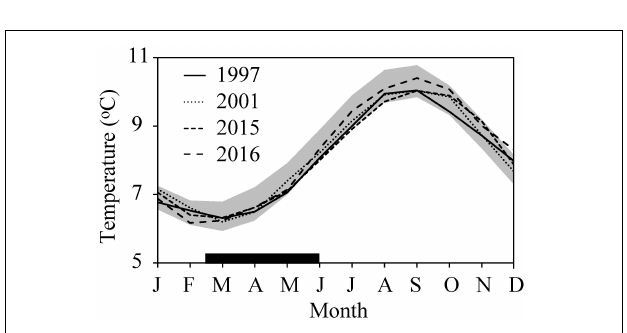
FIGURE 10 | Temperature in the CS in 1997, 2001, 2015, and 2016. The gray area highlights the one standard deviation range from the average for the years 1992–2016. The thick black horizontal line marks the larval and pelagic juvenile period of cod.